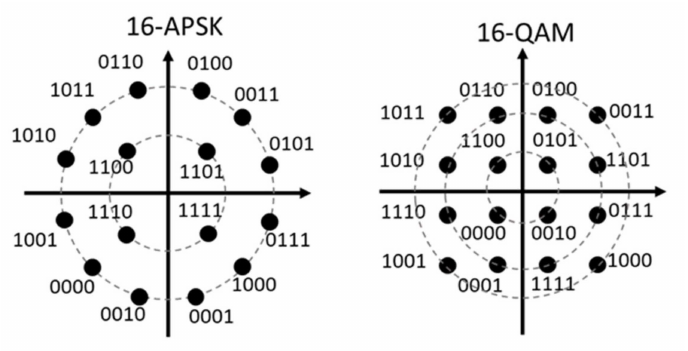
Figure 2. APSK and QAM modulation